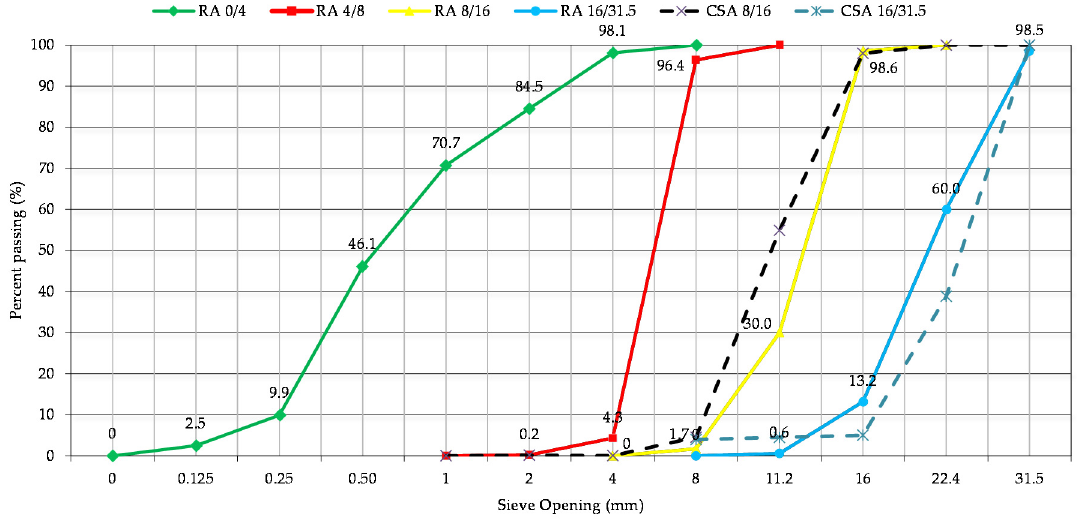
Figure 2. Particle-size distribution curves of river aggregate (RA) and copper slag aggregate (CSA).